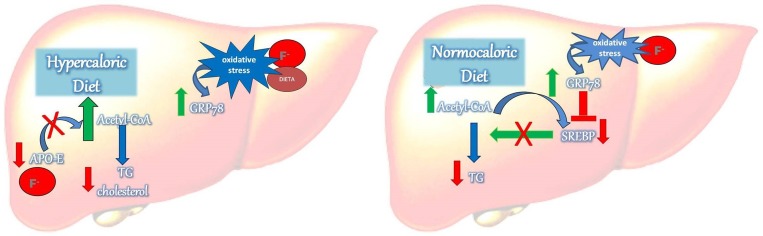
Proposed mechanism by which fluoride affects lipid metabolism depending on the type of diet consumed and time of exposure.The diet-dependency effects of fluoride in lipid metabolism are observed strictly at earlier periods and are related with ER oxidative stress. Upon consumption of normocaloric diet, fluoride-induced oxidative stress leads to increase of GRP78, which in turn reduces SREBP, thus deactivating TG synthesis. However, in the presence of hypercaloric diet, fluoride exposition induces oxidative stress highlighted by GRP78, ERp29 and SOD2 increases, which in turn, by undetermined mechanism, leads to reduction of Apo-E, which diminishes precursors of Acetyl–Coa and leads to less formation of liver TG.